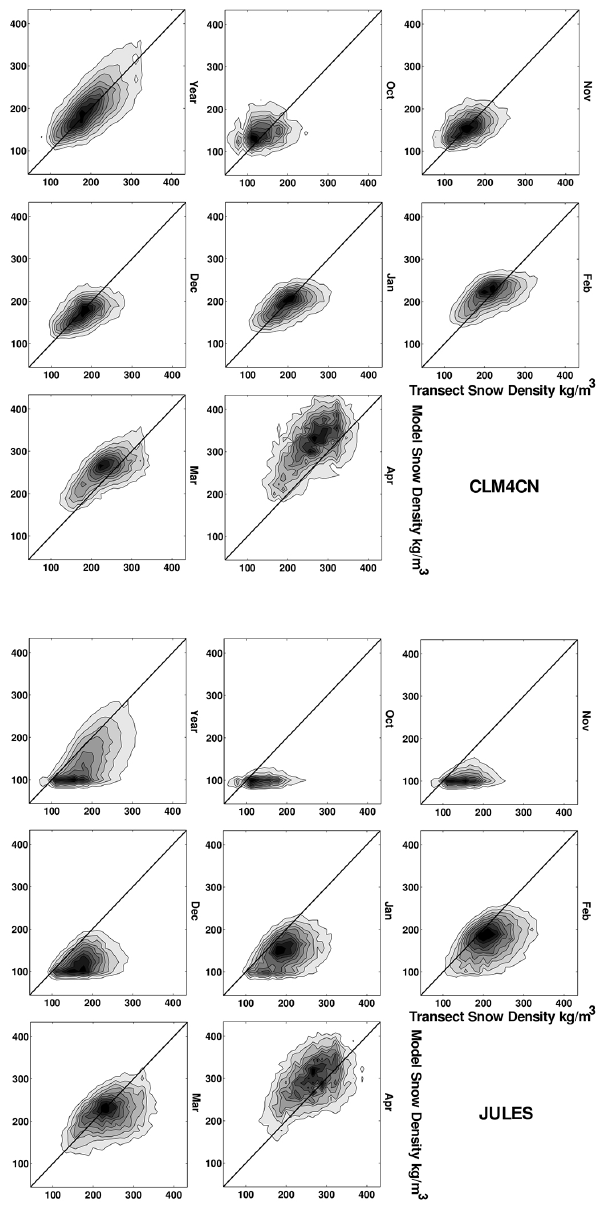
Fig. 4. Density histograms of monthly snow density for CLM4CN (top) and JULES (bottom) compared to the transect data set for the entire snow season (year) and for individual months, across the full spatial and temporal extent of the transect data set.